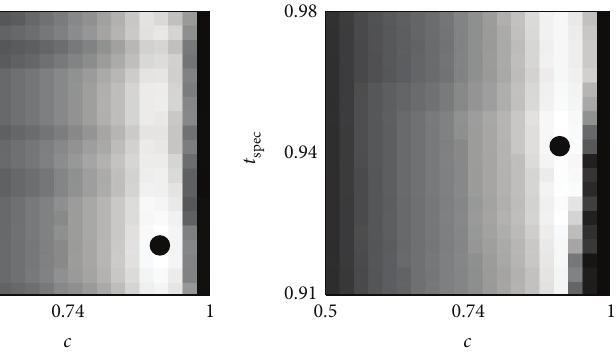
0.5 and 𝑐 = 0.92 Figure 3: Parameter optimization using the Jaccard index. The dot labels the optimal parameter values. The optimal parameters are used in the